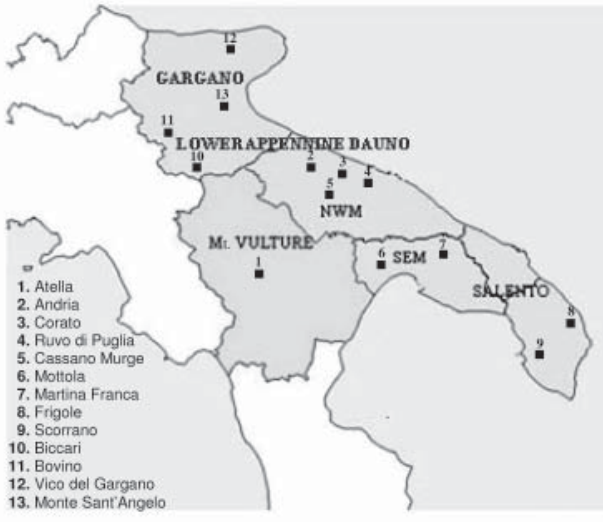
Fig. 1. Map of Apulia and Basilicata, Southern Italy, showing the localities (left column, 1–13) and areas of North-West Murge (NWM), South-East Murge (SEM), Salento, Gargano, Lower Appennine Dauno and Monte Vulture where basidiomes of Phellinus torulosus were